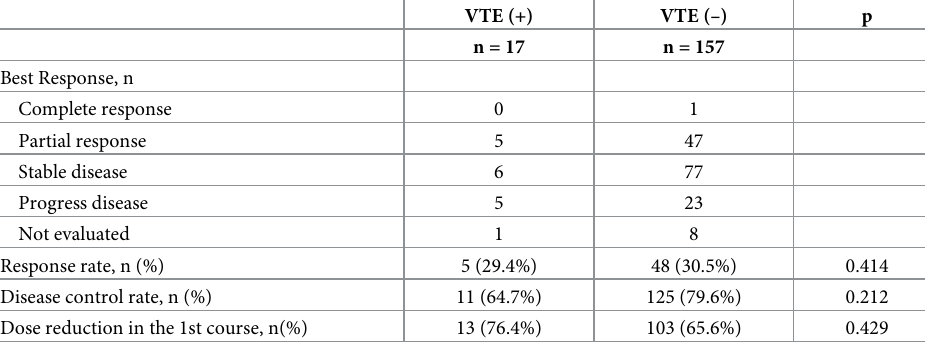
Table 2. Tumor response and dose reduction in the 1st course of